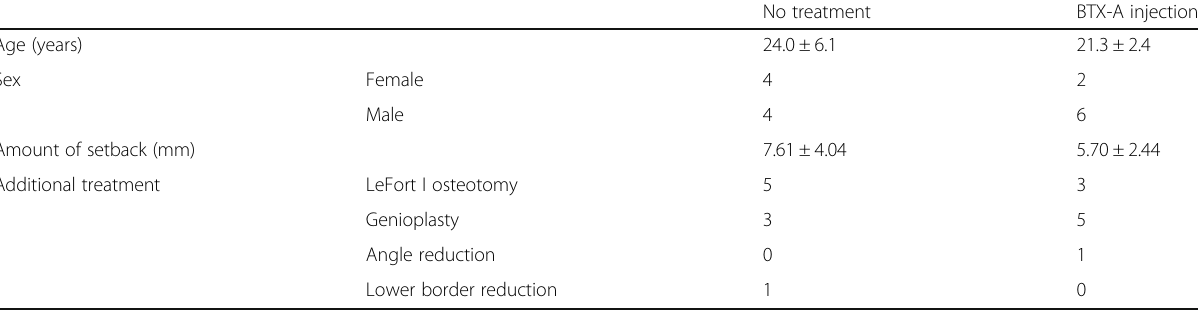
Table 1 Summary of